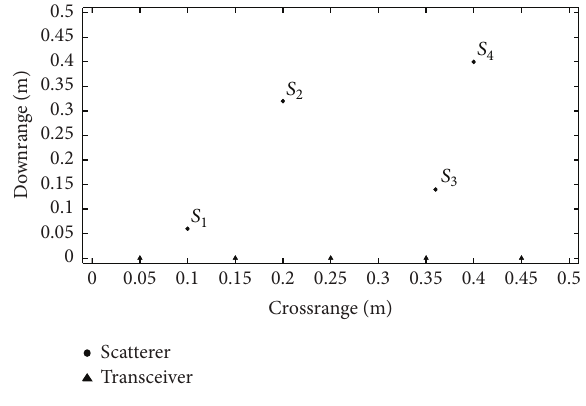
Figure 1: Setup of numerical